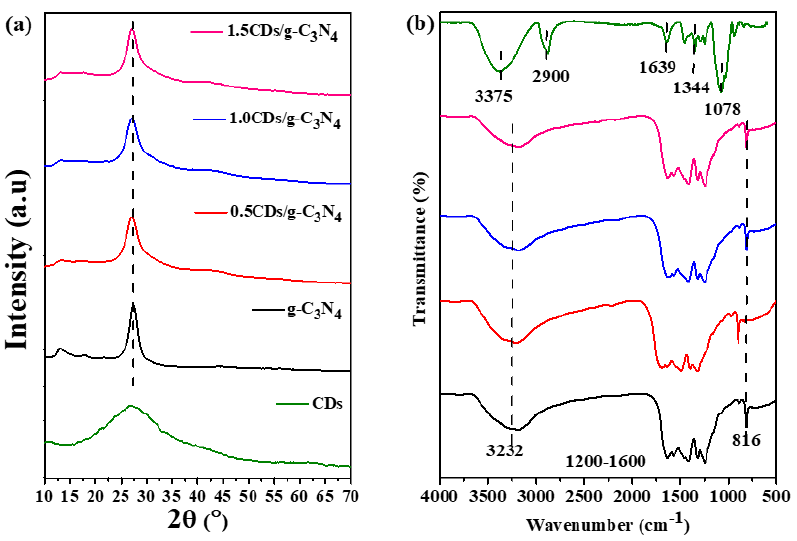
Figure 1. The ( a ) XRD diffractograms and ( b ) FT ‐ IR spectra of CDs, pure g ‐ C 3 N 4 , 0.5CDs/g ‐ C 3 N 4